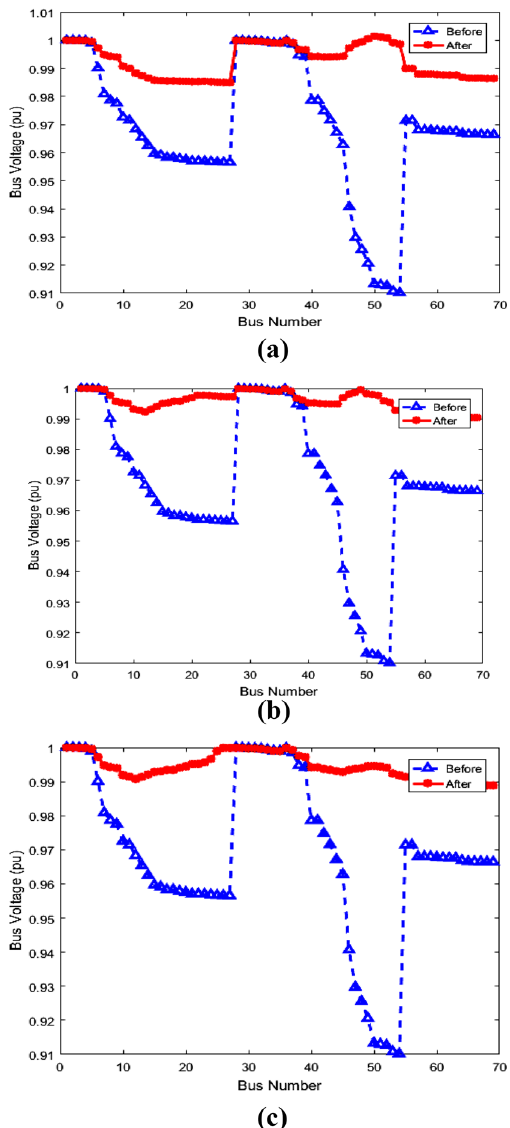
Fig. 10 The graph of voltage profiles in the 69-bus network, a unit resulting, b 0.85 Post-phase, c 0.85